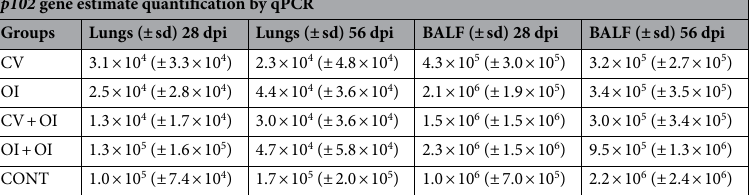
Table 2. Results of p102 gene estimate quantification by qPCR in lungs and BALF of piglets from all experimental groups at the 28th and 56th days post-infection. No statistical differences were observed between groups or time-points.